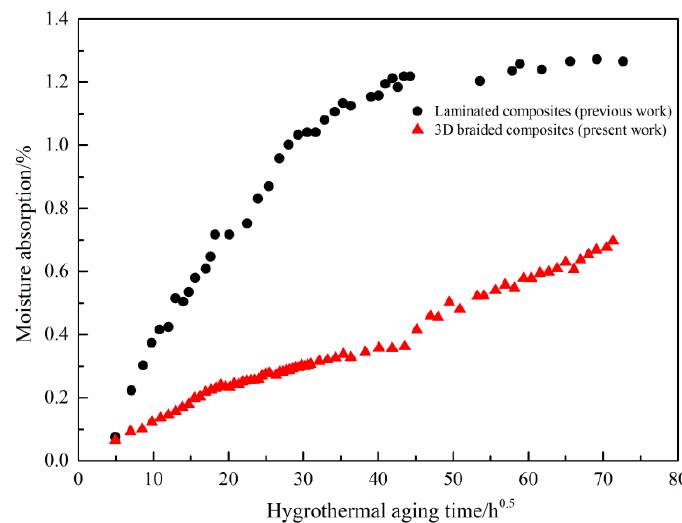
Figure 9. Contrast of moisture absorption between the 3D four-step braided composites and the T700/TDE85 laminated composites during 210 cyclic hygrothermal aging days.